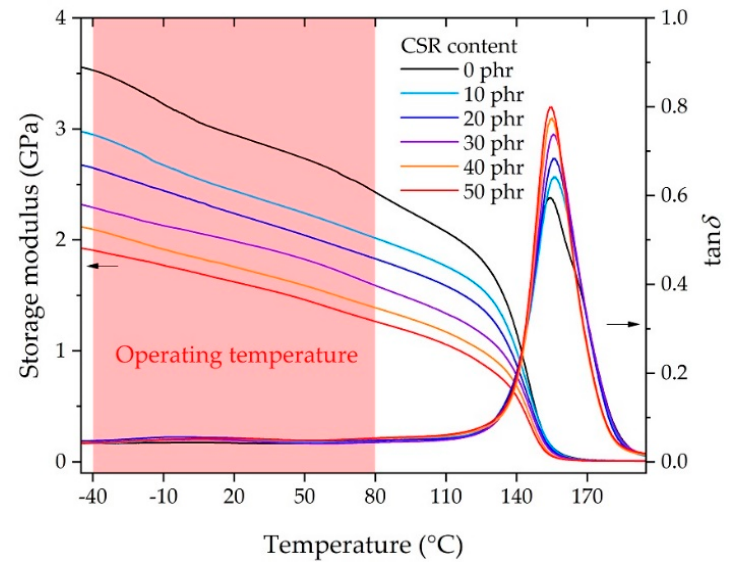
Figure 4. Storage modulus and tan δ measured by dynamic mechanical analyzer (DMA).